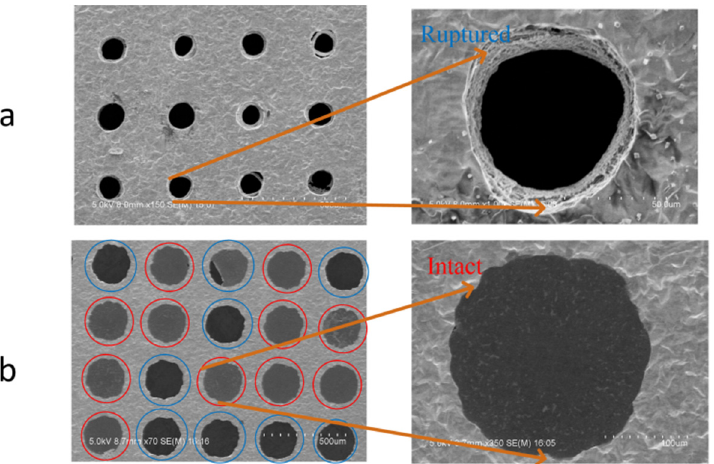
Figure 8. The SEM image of method 1 and method 3 after removing the PMMA. ( a ) The image of 80 µ m suspended graphene transferred by method 1. ( b ) The image of 200 µ m suspended graphene transferred by method 3.